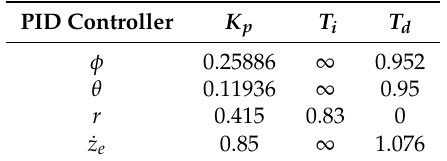
Table 1. Pid parameters using the Root-Locus method.